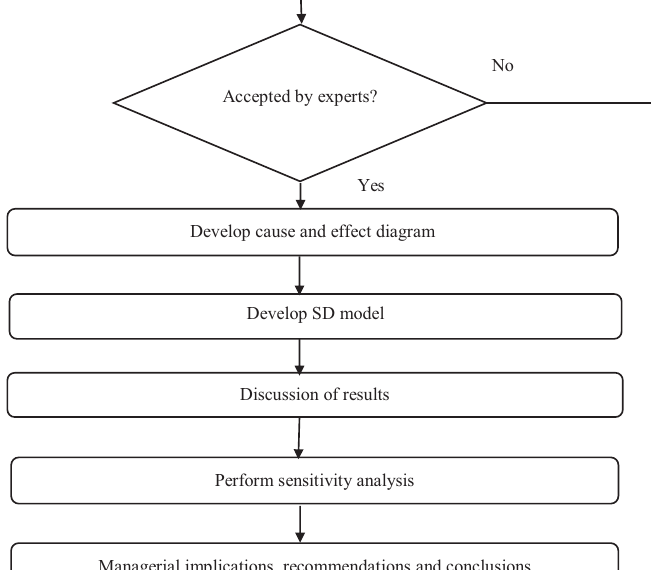
Figure 1. Flow diagram of the current